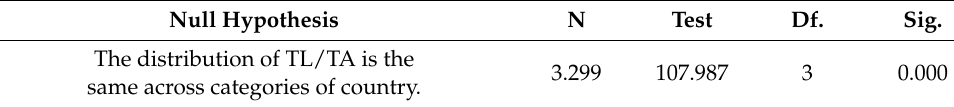
Table 6. Hypothesis Test Summary—Kruskal-Wallis Test.